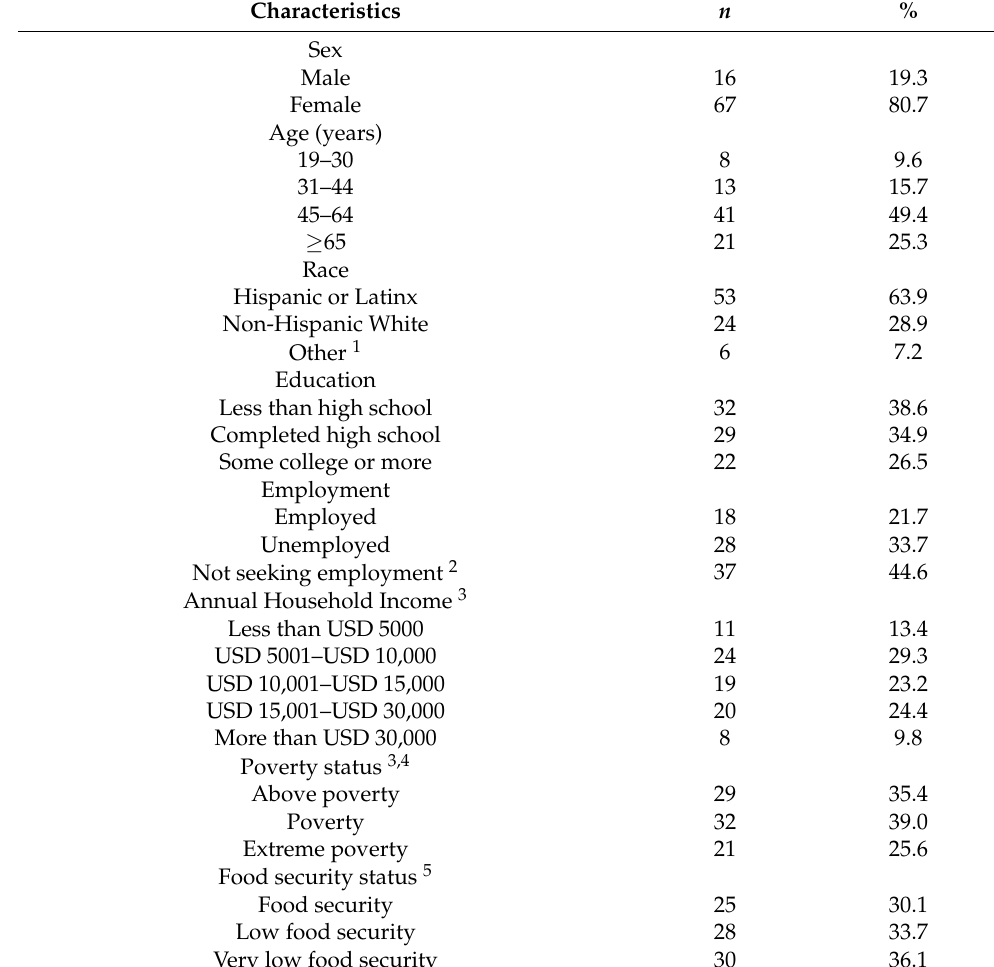
Table 1. Sociodemographic characteristics of study participants ( n = 83) recruited from mobile food pantries in Windham County,